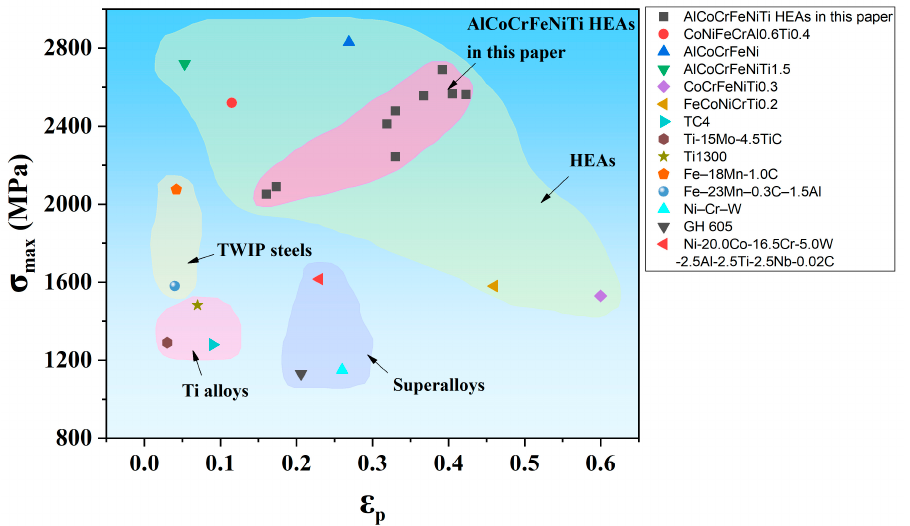
Figure 10. Ashby plot including properties of AlCoCrFeNiTi HEAs in this paper, CoNiFe- CrAl0.6Ti0.4 [40], AlCoCrFeNi [41], AlCoCrFeNiTi1.5 [41], CoCrFeNiTi0.3 [42], FeCoNiCrTi0.2 [43], Ti alloys (TC4 [44], Ti-15Mo-4.5TiC [45] and Ti1300 [46]), TWIP steels (Fe–18Mn-1.0C [47] and Fe– 23Mn–0.3C–1.5Al [48]), Superalloys (Ni–Cr–W [49], GH 605 [50] and Ni-20.0Co-16.5Cr-5.0 W-2.5Al- 2.5Ti-2.5Nb-0.02C [51]).